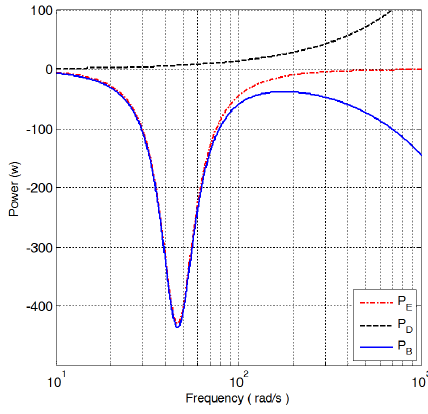
Figure 7. The averaged powers when k p =